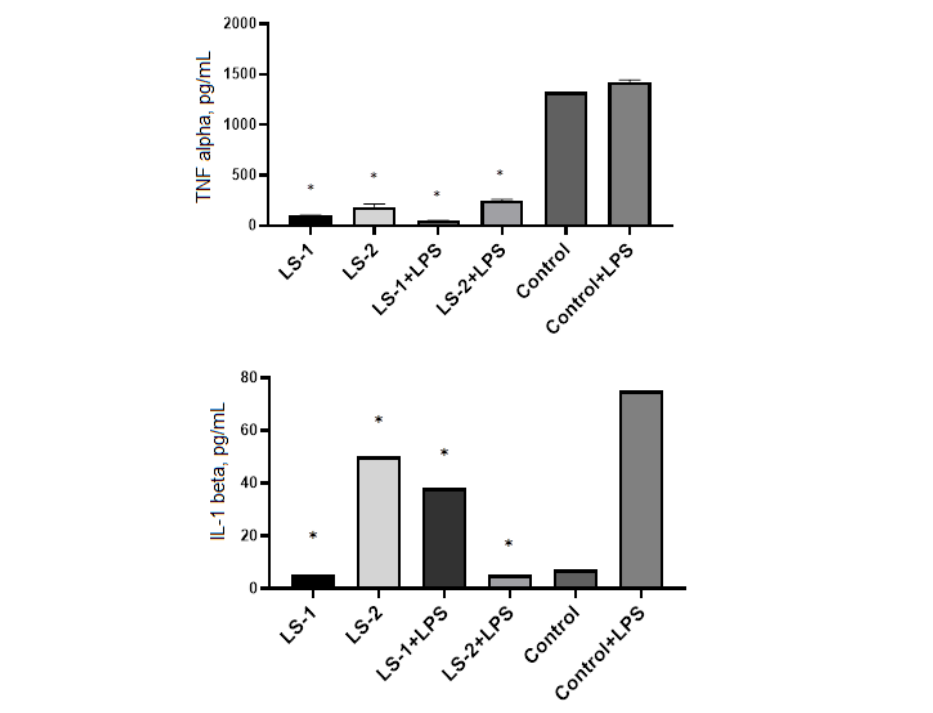
Figure 6. Effects of S. deserta Schang extracts on the secretion of TNF- α and IL-1 β by murine peritoneal macrophages. (LS-1)—sage extract obtained by conventional extraction and (LS-2)—sage extract obtained by ultrasonic-assisted extraction. Two controls were used in the experiment: macrophages without treatment or stimulus and macrophages activated with LPS. (*) indicates significant differences in comparison to control, p < 0.05.